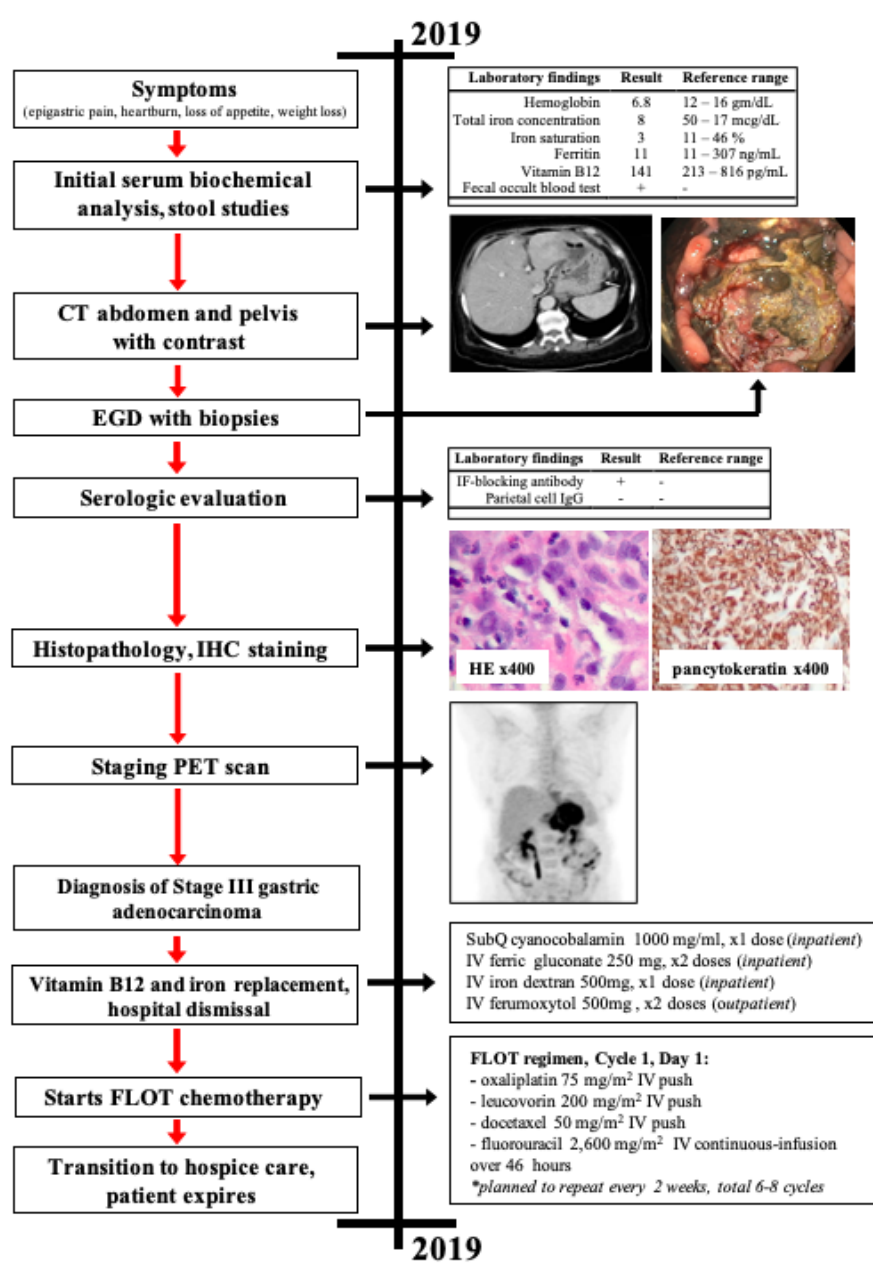
Figure 5. Case report timeline. Presented according to CARE guidelines.